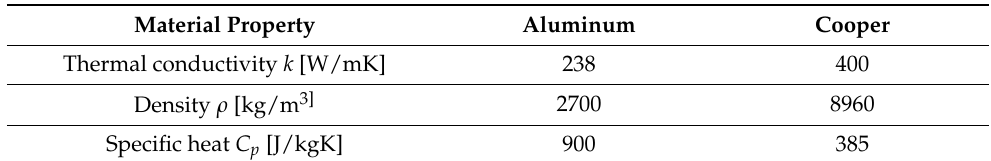
Figure 7. Model Boundary conditions. Table 2. Solid material properties.